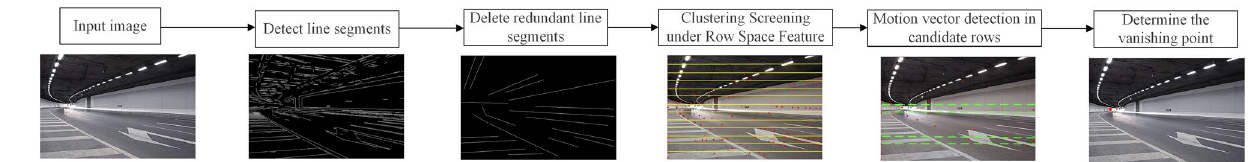
Figure 1. Flowchart of the proposed vanishing point detection.